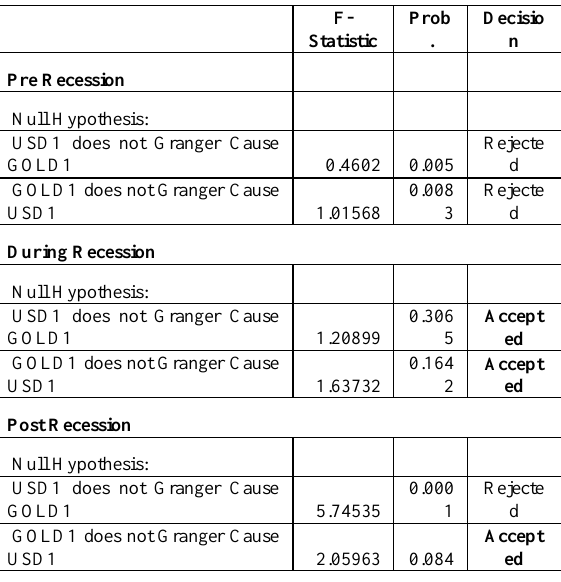
Table 4: The Result of Pair wise Granger Causality Tests between Gold USD Exchange